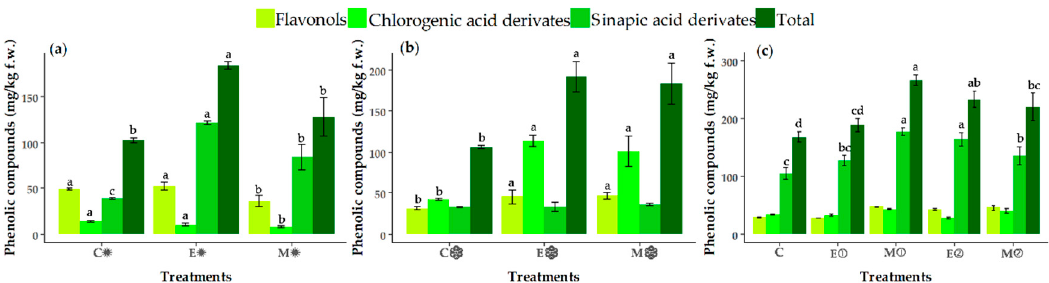
Figure 3. Contents of individual phenolic compounds (flavonols, chlorogenic acid derivates and sinapic acid derivates) and the total contents of phenolic compounds determined as the sums of the individual compounds (mg/kg f.w.), analyzed by HPLC-DAD for the samples of the spring assay ( a ) (C ✹ , E ✹ , M ✹ ), autumn assay ( b ) (C ❄ , E ❄ , M ❄ ) and dosage assay ( c ) (C, E , M , E , M ): C (control), E (excipient), M (MeJA), ✹ (spring), ❄ (autumn), (one application MeJA) and (two applications MeJA). Values are expressed as the mean ± SD. Different letters (a-d) indicate significant differences ( p < 0.05) among the samples of each assay for the individual and total phenolic compounds ( n = 3).